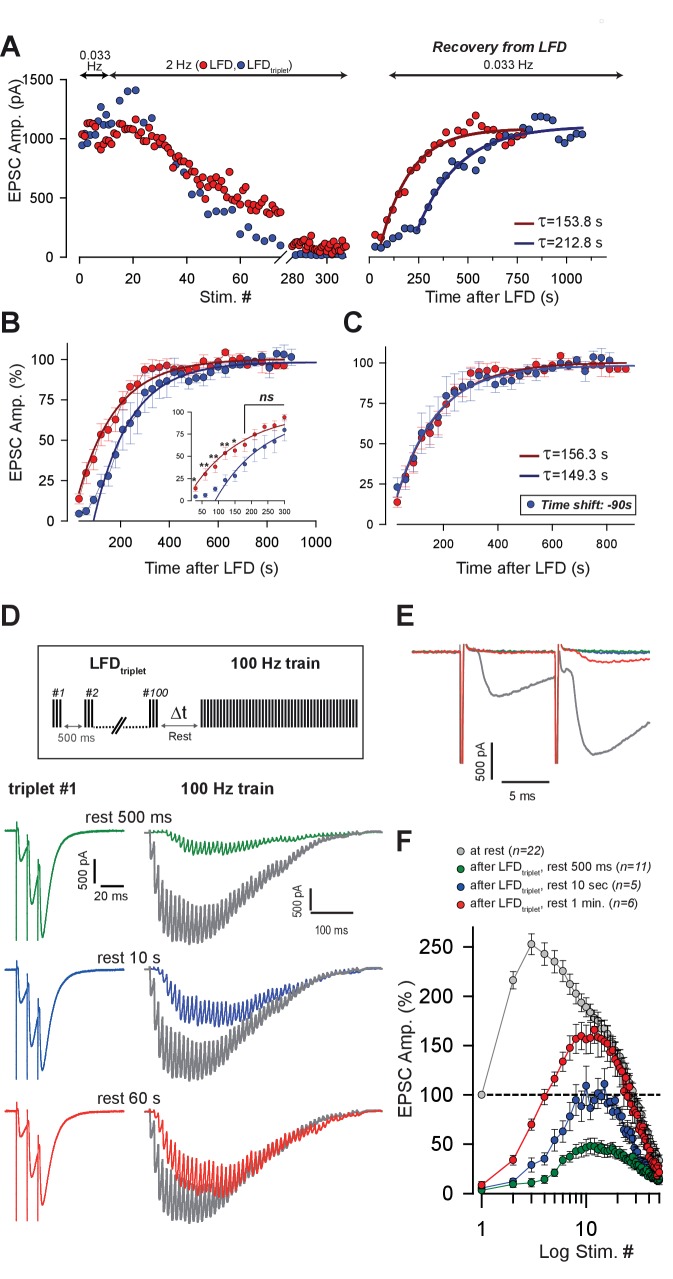
Kinetics of recovery from LFD and LFDtriplet. (A) Left, superimposition of the time course of LFD and LFDtriplet (triplet stimulation at 200 Hz) elicited successively in the same cell after establishing a baseline of at least 10 successive stimuli at 0.033 Hz. Right, recovery from depression probed 30 s after the end of both LFD and LFDtriplet by a 0.033 Hz stimulation. For clarity, EPSC amplitudes were plotted against stimulus number in the left graph and against time in the right graph. The thick red and blue lines on the right graph show monoexponential fits. Note the delay of recovery after LFDtriplet, stimulation. (B) Normalized mean amplitudes of EPSCs evoked by 0.033 Hz stimulation 30 s after LFD (red points, n = 8) and after LFDtriplet (triplet stimulation at 200 Hz, blue points, n = 6). EPSC amplitudes were normalized to the mean value of EPSCs recorded during a baseline established by stimulation at 0.033 Hz. Thick red and blue lines represent monoexponential fits. (C) same values as in B, except that the time axis was shifted by 90 s for experimental values obtained during the recovery train applied after LFDtriplet (blue points). (D) Recovery from LFDtriplet probed by 100 Hz as indicated by the stimulation paradigm. Left, EPSC traces recorded during the 1st triplet stimulation at 2 Hz. Right, EPSC traces recorded during 100 Hz trains applied 500 ms, 10 s or 60 s after LFD protocol ended. Traces are superimposed with EPSCs recorded during a 100 Hz train applied before LFD induction (gray traces). (E) Superimposition of the first responses to the trains recorded in D. The color code is the same as in D. (F) Mean values of EPSC amplitudes recorded during 100 Hz trains applied 500 ms, 10 s or 60 s after the LFD protocol ended.